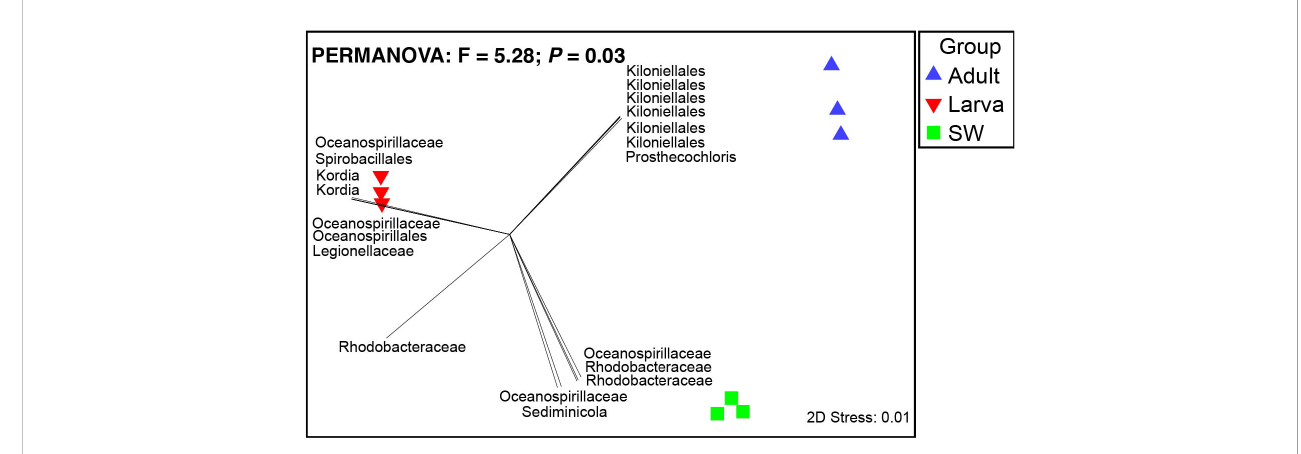
FIGURE 4 Non-metric multi-dimensional scaling analysis of microbial communities in seawater, coral larvae, and adults. Pearson correlation vectors represent the most resolved taxonomy for bacterial